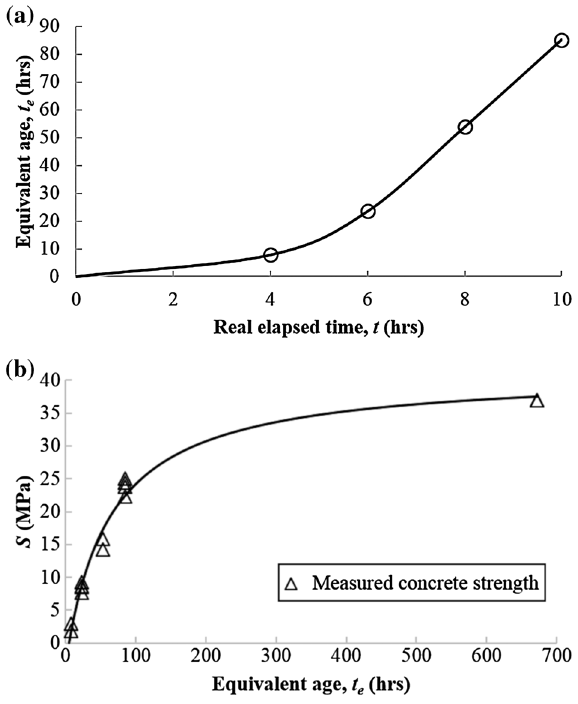
Fig. 6 Development of concrete strength at different t e . a The relationships between real elapsed time and t e and b prediction of concrete strength S at different t e